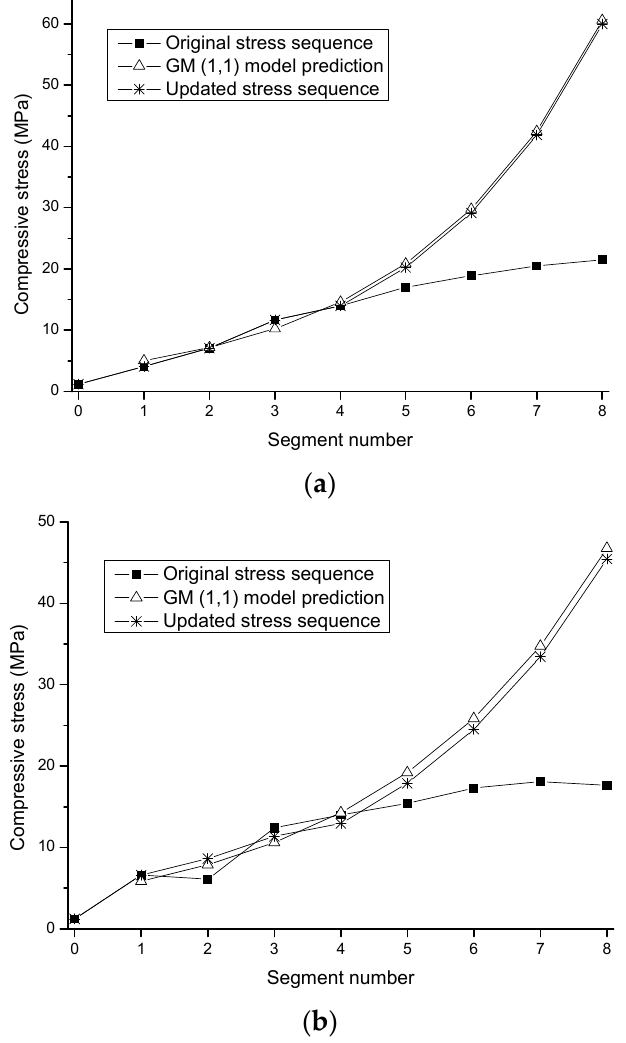
Figure 8. Stress sequences measured on location and predicted by GM (1,1) models. ( a ) B ‐ B cross ‐ section. ( b ) C ‐ C cross ‐ section.